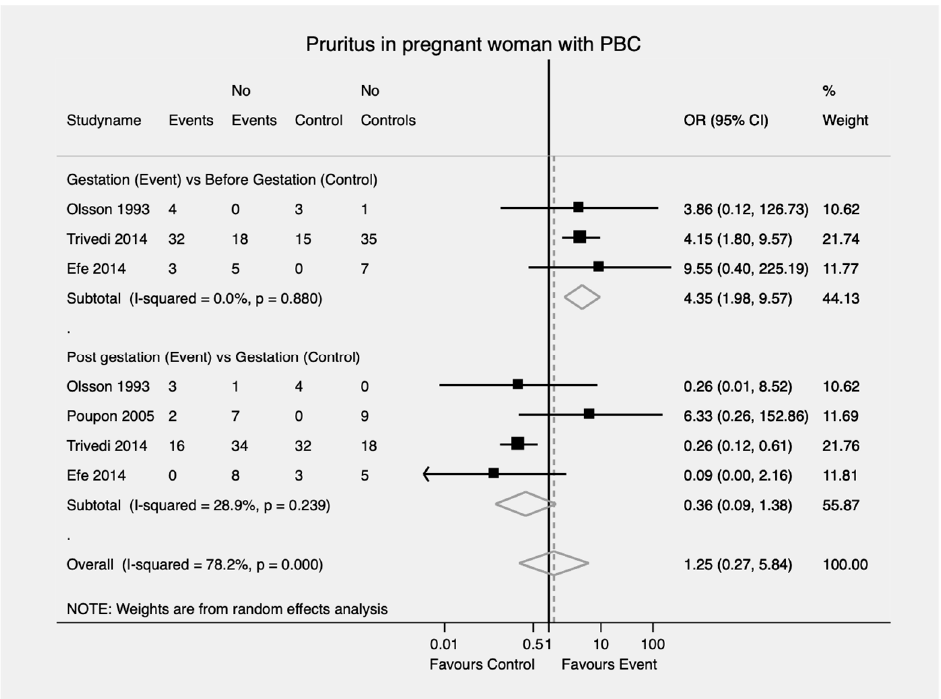
Figure 4. Pruritus in pregnant woman with PBC. PBC—Primary biliary cholangitis; OR—Odds ratio; CI—Confidence interval.